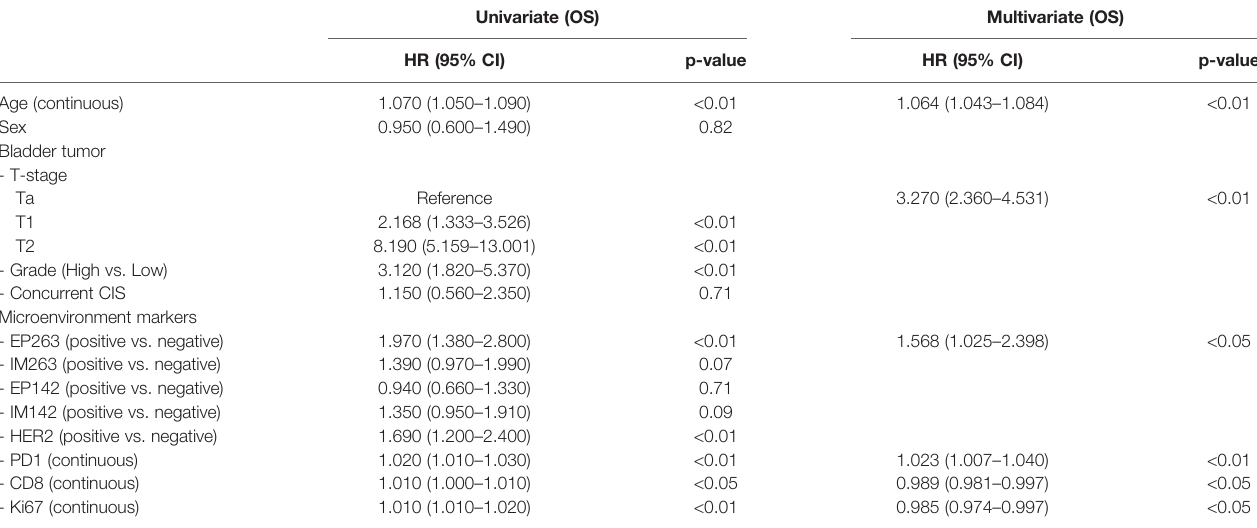
TABLE 2 | Univariate and multivariate analyses of OS in all